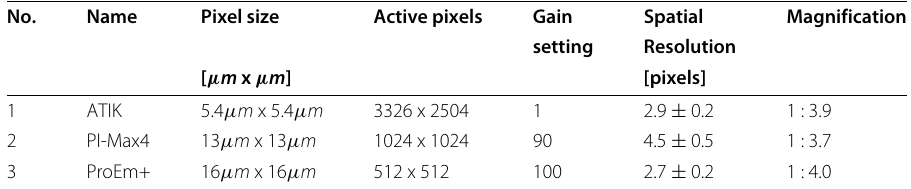
Table 2 Information taken from